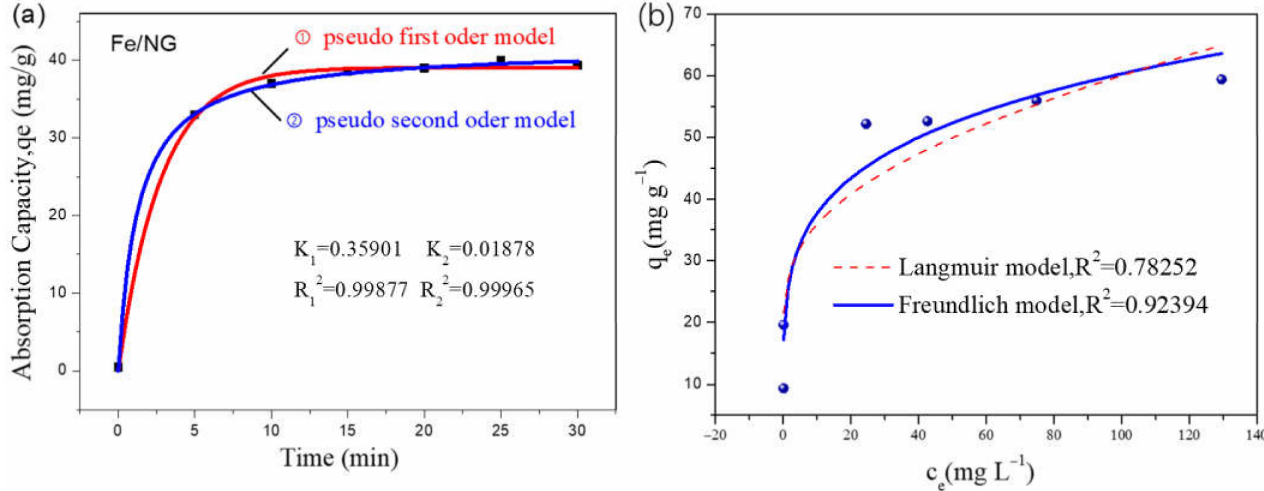
Figure 9. ( a ) Pseudo-first-order and pseudo-second-order for MB adsorption onto Fe/NG: C 0MB = 40 mg L − 1 , m/V = 1 g L − 1 . ( b ) Adsorption isotherms for MB adsorption onto Fe/NG at different equilibrium